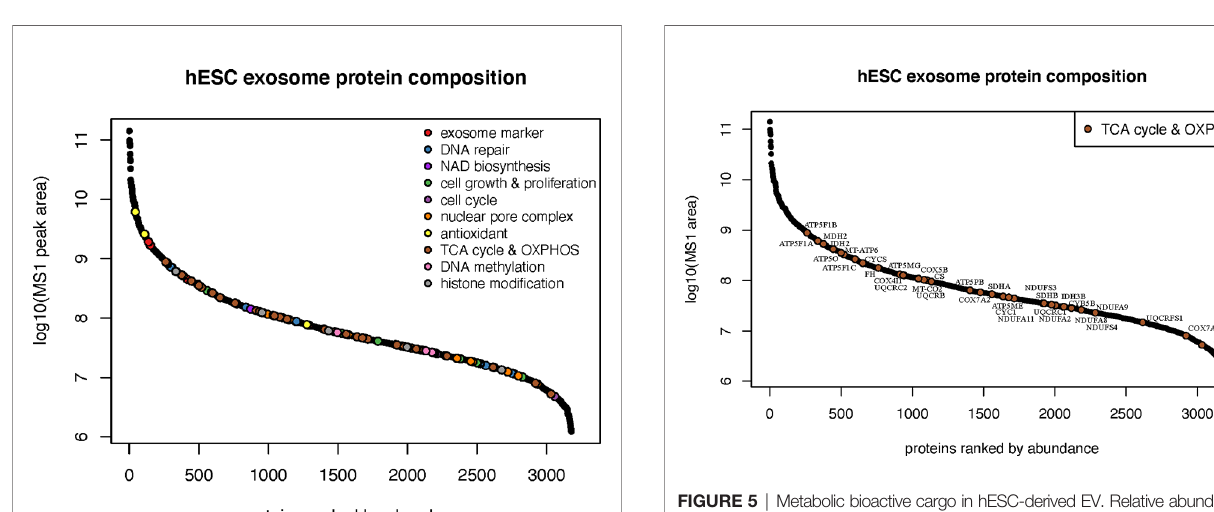
FIGURE 5 | Metabolic bioactive cargo in hESC-derived EV. Relative abundance of metabolic proteins known to participate in the tricarboxylic acid cycle and mitochondrial oxidative phosphorylation identi fi ed by proteomic